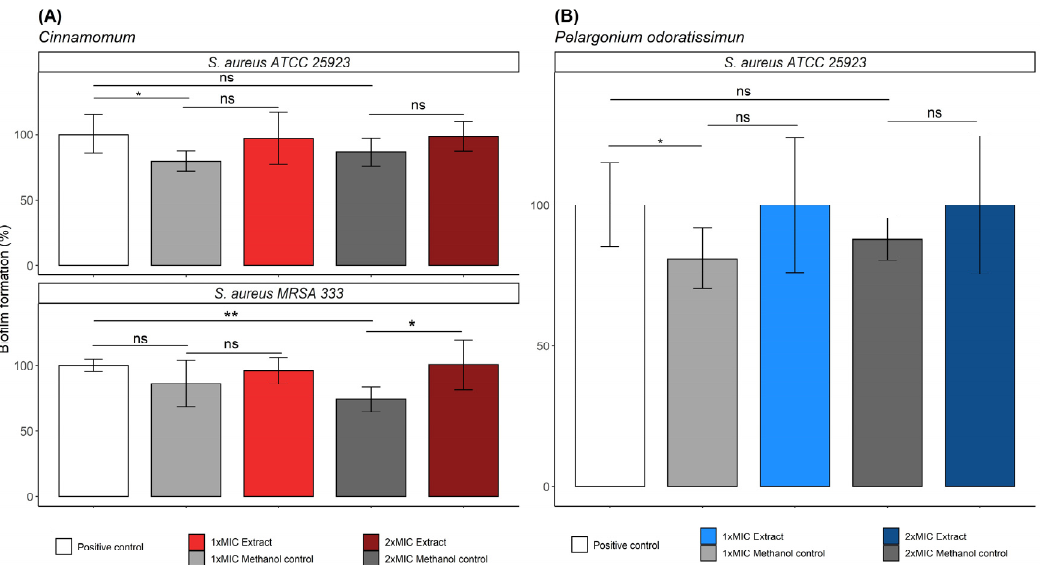
Figure 2. Representative illustration of the biofilm eradication assays using extracts from plants used in the herbal infusion horchata. ( A ) Evaluation of the antibiofilm activity of Cinnamomum sp. extract against S. aureus and MRSA 333. ( B ) Evaluation of the antibiofilm activity of Pelargonium odoratissimum extract against S. aureus . All statistical analyses ( p -values) were analysed using a nonparametric Mann–Whitney test (95% confidence interval) for comparison between biofilm formation values, where: * p -values < 0.05; ** p -values < 0.01; and ns: nonsignificant p -value.